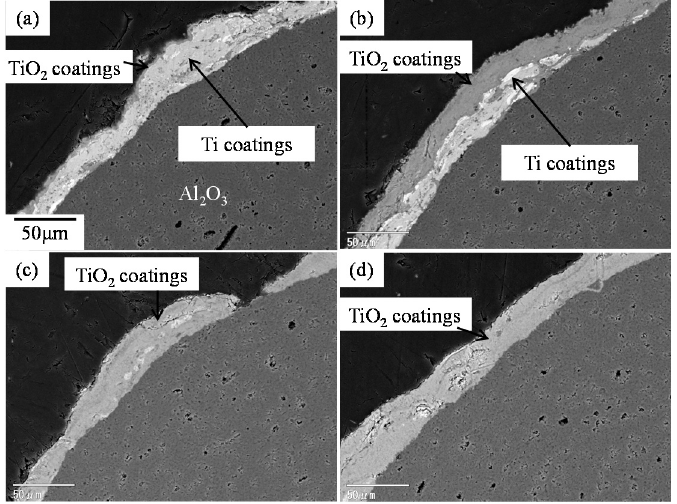
Figure 45. Cross-section SEM images of the M10-1%Ni- x K samples. ( a ) 973 K, ( b ) 1073 K, ( c ) 1173 K, ( d ) 1273 K.